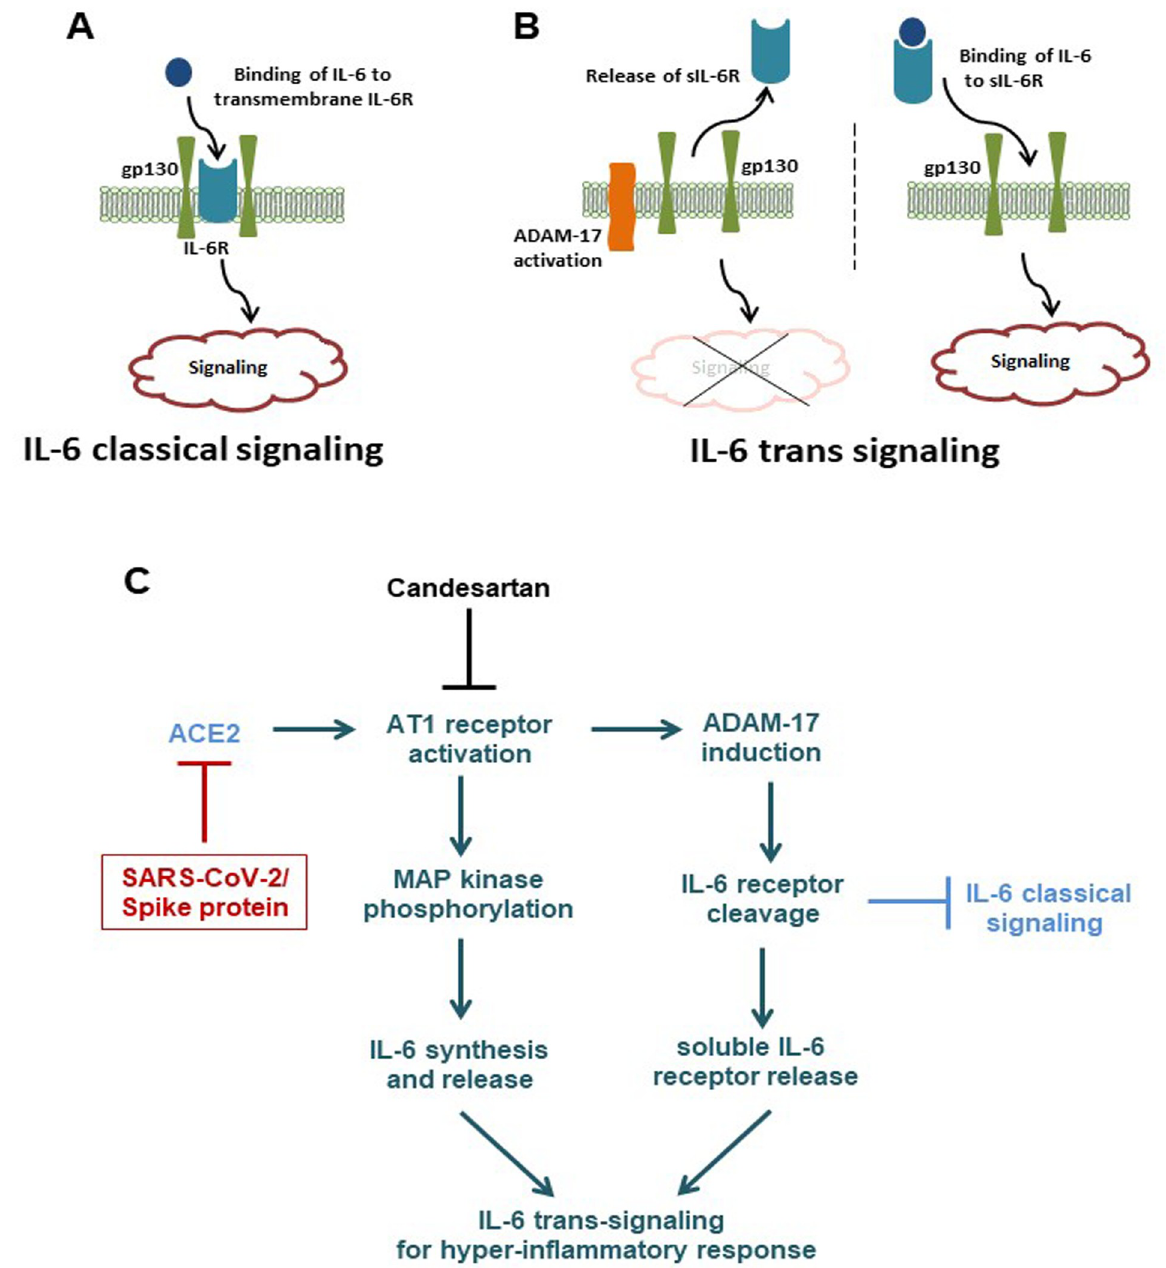
Fig 9. (A, B) Overview of IL-6 mediated classical and trans-signaling mechanisms. (C) Schematic presentation of molecular changes occurring upon SARS-CoV-2 infection or spike protein expression in epithelial cells.